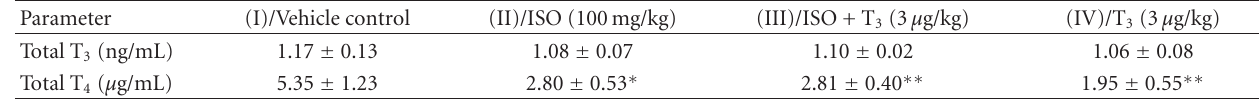
Table 2: Summary of hormonal profile.